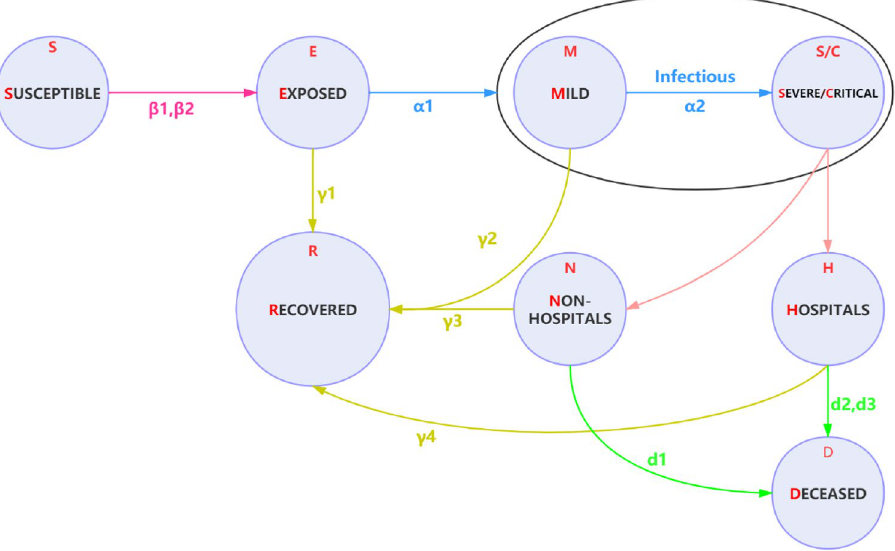
Figure 8. Extended SEMCR model structure: the population is divided into the following six classes: susceptible, exposed (and not yet symptomatic), infectious (symptomatic), mild (mild or moderate symptom), critical (severe symptom), deceased and recovered (i.e., isolated, recovered, or otherwise